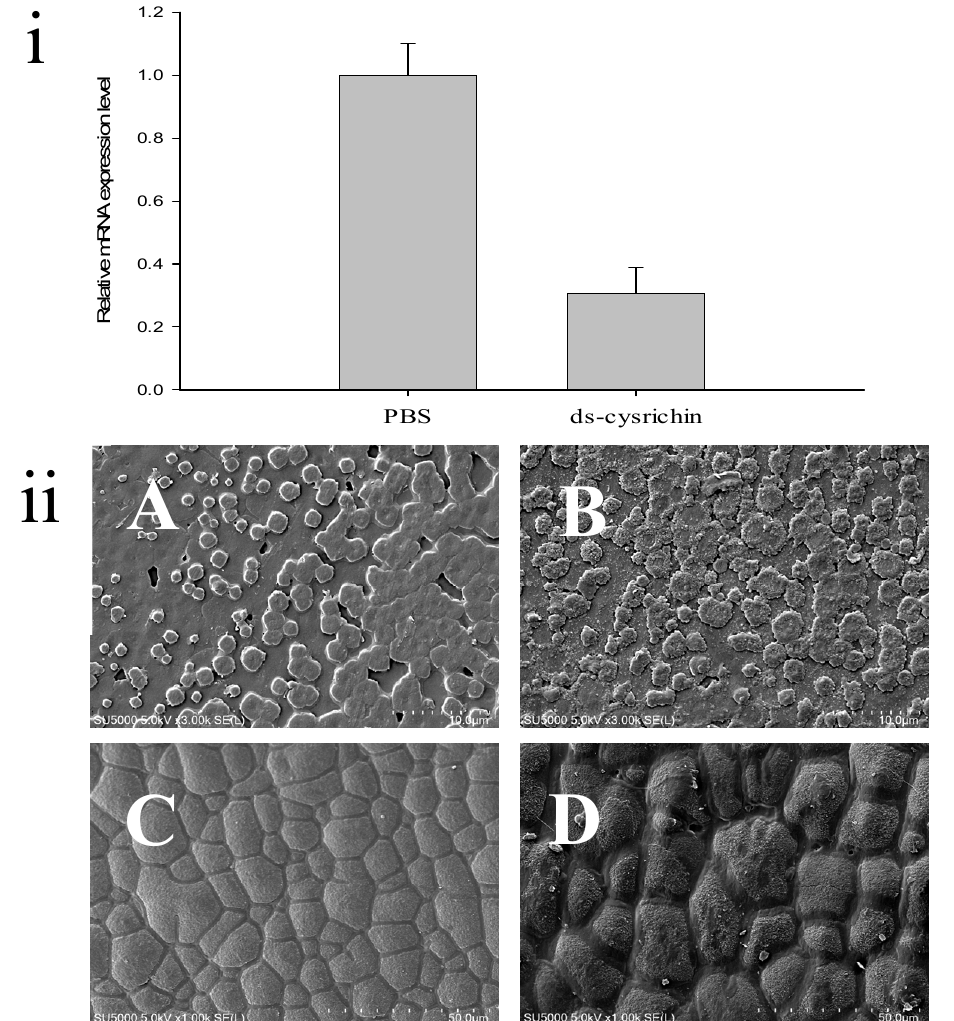
Figure 6. Influence of cysrichin on the morphology of newly formed crystals on the shell. ( i ) The relative expression level of cysrichin after RNAi; ( ii ) Crystal morphology of the shell surface after RNAi. Note: ( A , B ) The nacreous layer; ( C , D ) The prismatic layer; ( A , C ) The PBS group; ( B , D ) The ds-cysrichin group.